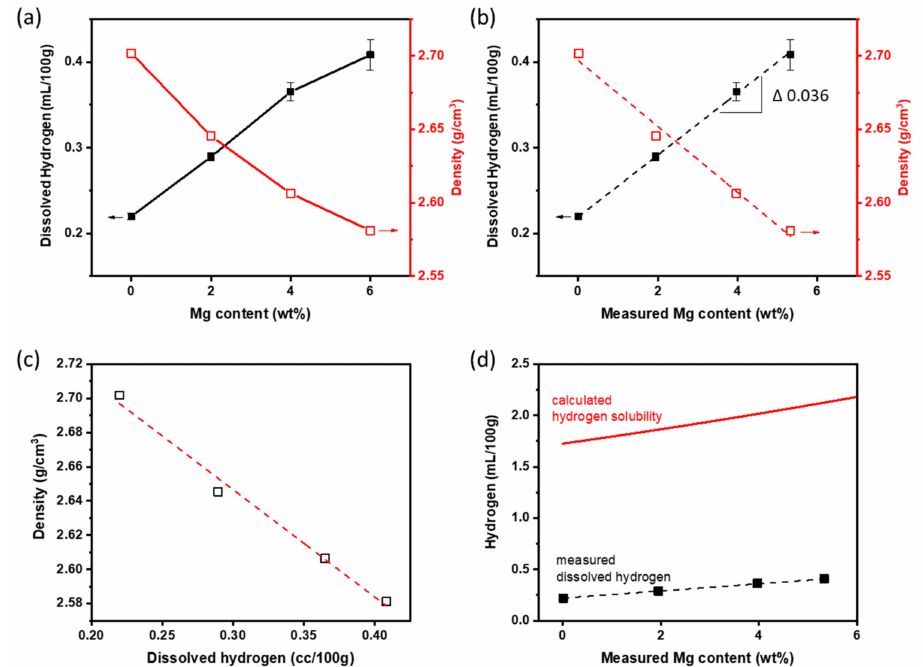
Figure 2. Dissolved hydrogen content [H] in the Al-Mg alloy melt at 800 ◦ C and the density of the alloys after casting the melt as a function of ( a ) nominal X Mg , and ( b ) measured X Mg . ( c ) Relationship between the density and the [H] of the alloys. ( d ) Calculated hydrogen solubility and measured [H] in the Al-Mg alloy melt at 800 ◦ C according to X Mg